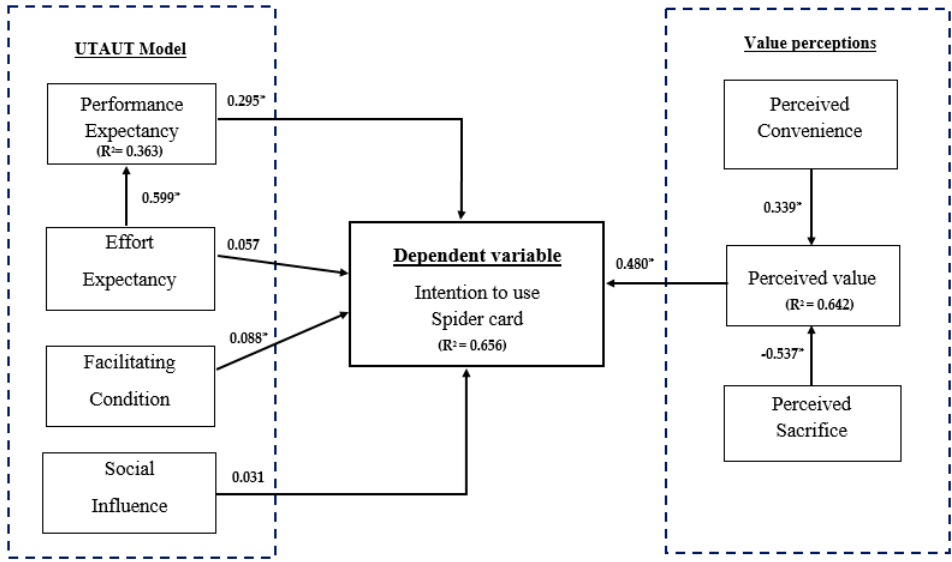
Figure 2. Standardised path coefficients. (Note: * indicate the significant at the p < 0.05